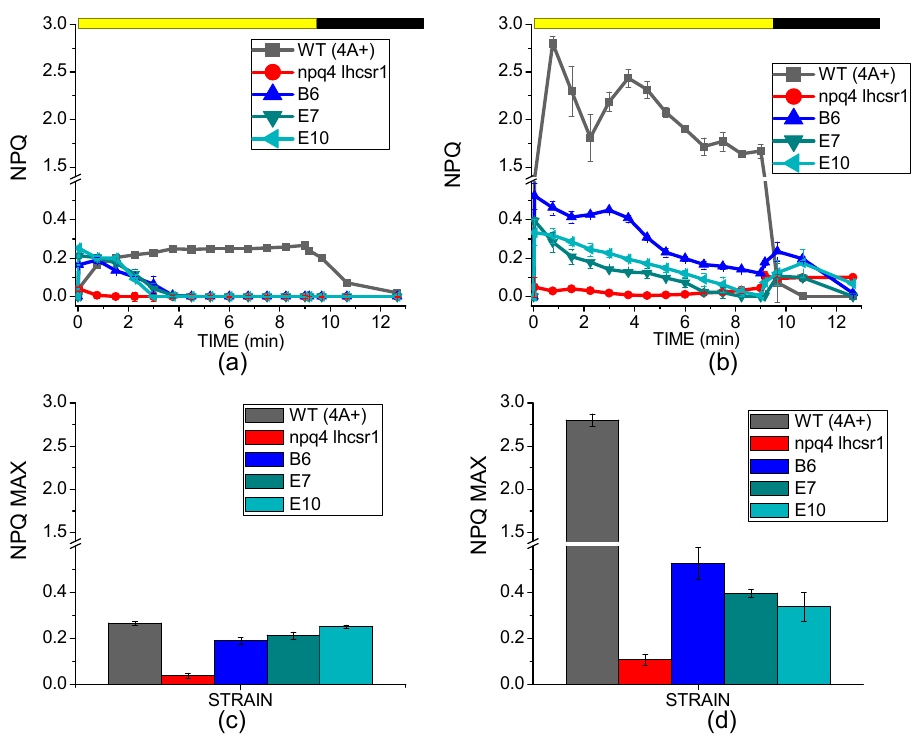
Figure 3. NPQ kinetics and NPQ maximum induction. ( a , b ): NPQ kinetics measured in cells grown in low light ( a ) or high light ( b ) upon actinic light illumination (1200 µ mol m − 2 · s − 1 ), and dark recovery. Yellow bar indicates the illumination period and the dark bar indicates the dark recovery; ( c , d ): maximum NPQ values detected for WT, transformed lines and their background npq4 lhcsr1 grown in low light ( c ) or high light ( d ) with standard deviation reported as error bar ( n = 3).